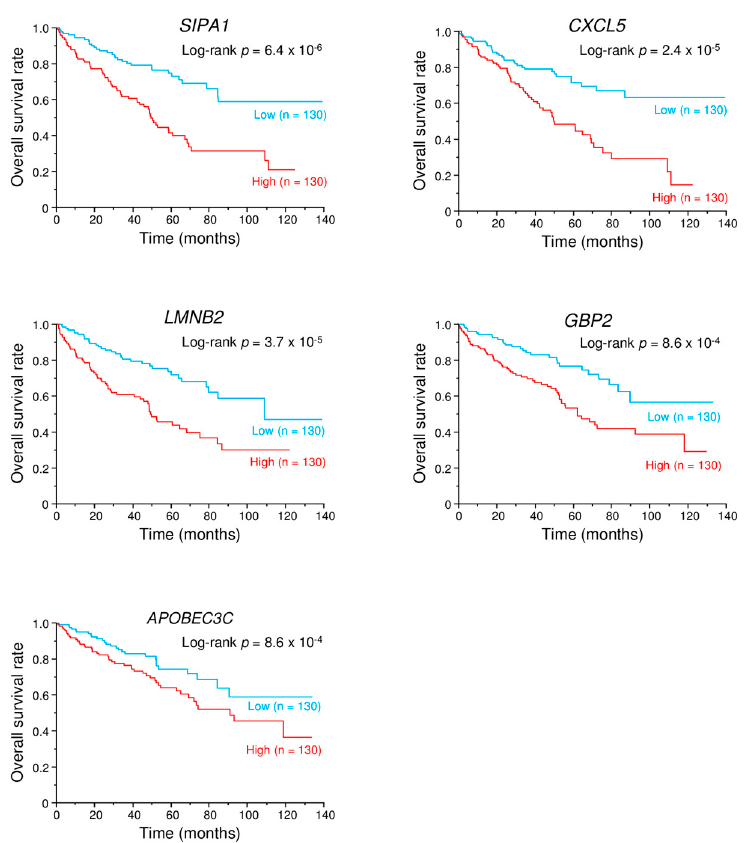
Figure 8. Kaplan-Meier survival analysis. Kaplan-Meier survival curves based on putative target genes regulated by miR-149-5p and miR-149-3p in patients with ccRCC.